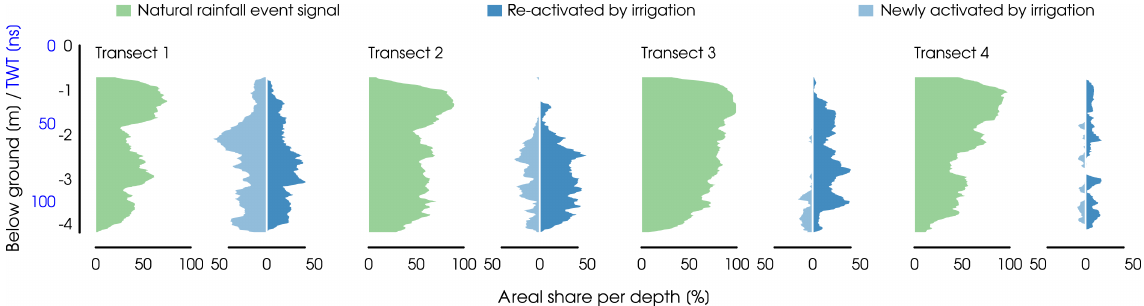
Figure 12. Areal share of activated regions per depth for the natural rainfall event and the irrigation. Areal share of activated regions for the natural rain event were calculated from the first measurement only (also depicted in Fig. 6a). Values for the irrigation experiment were accumulated over all GPR measurements, counting every pixel that had been activated after irrigation start. Here, we distinguish between pixels that had been active before irrigation start and were re-activated again, and pixels which have not been active previously and were newly activated by irrigation.